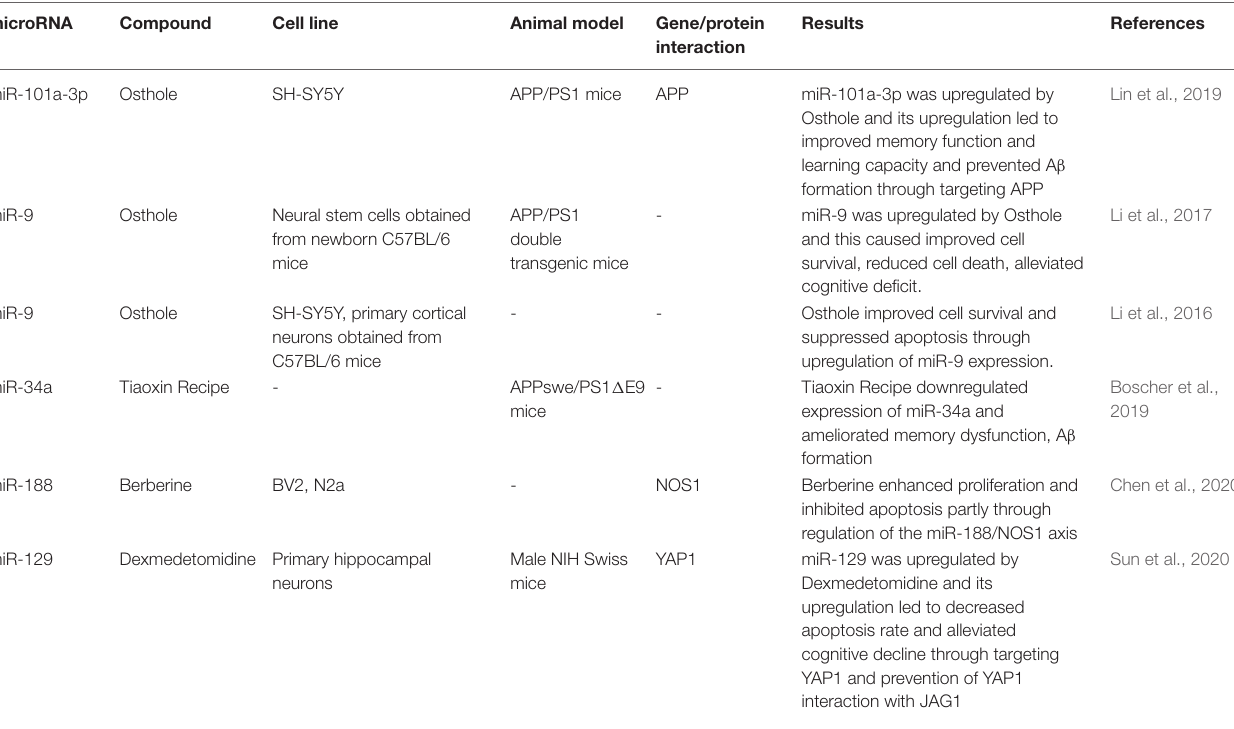
TABLE 5 | Effect of different compounds on